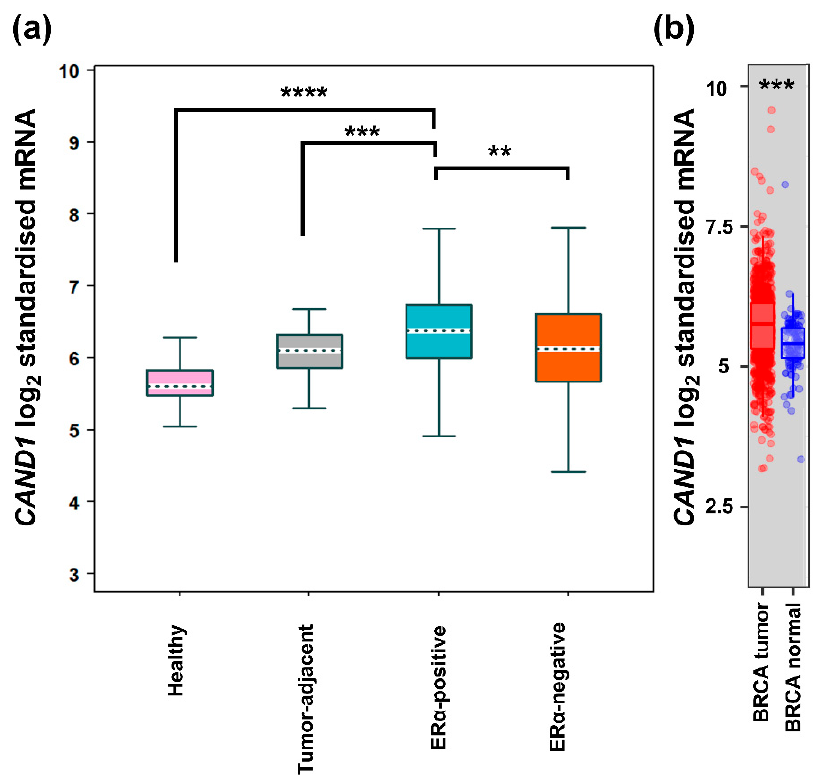
Figure 1. ( a ) CAND1 mRNA expression in normal, tumor-adjacent, ER α -positive and -negative breast cancer tissues using bc-GenExMiner; ( b ) CAND1 mRNA expression in normal and breast cancer tissue using TIMER2.0. ** p < 0.01, *** p < 0.001, and **** p < 0.0001 .